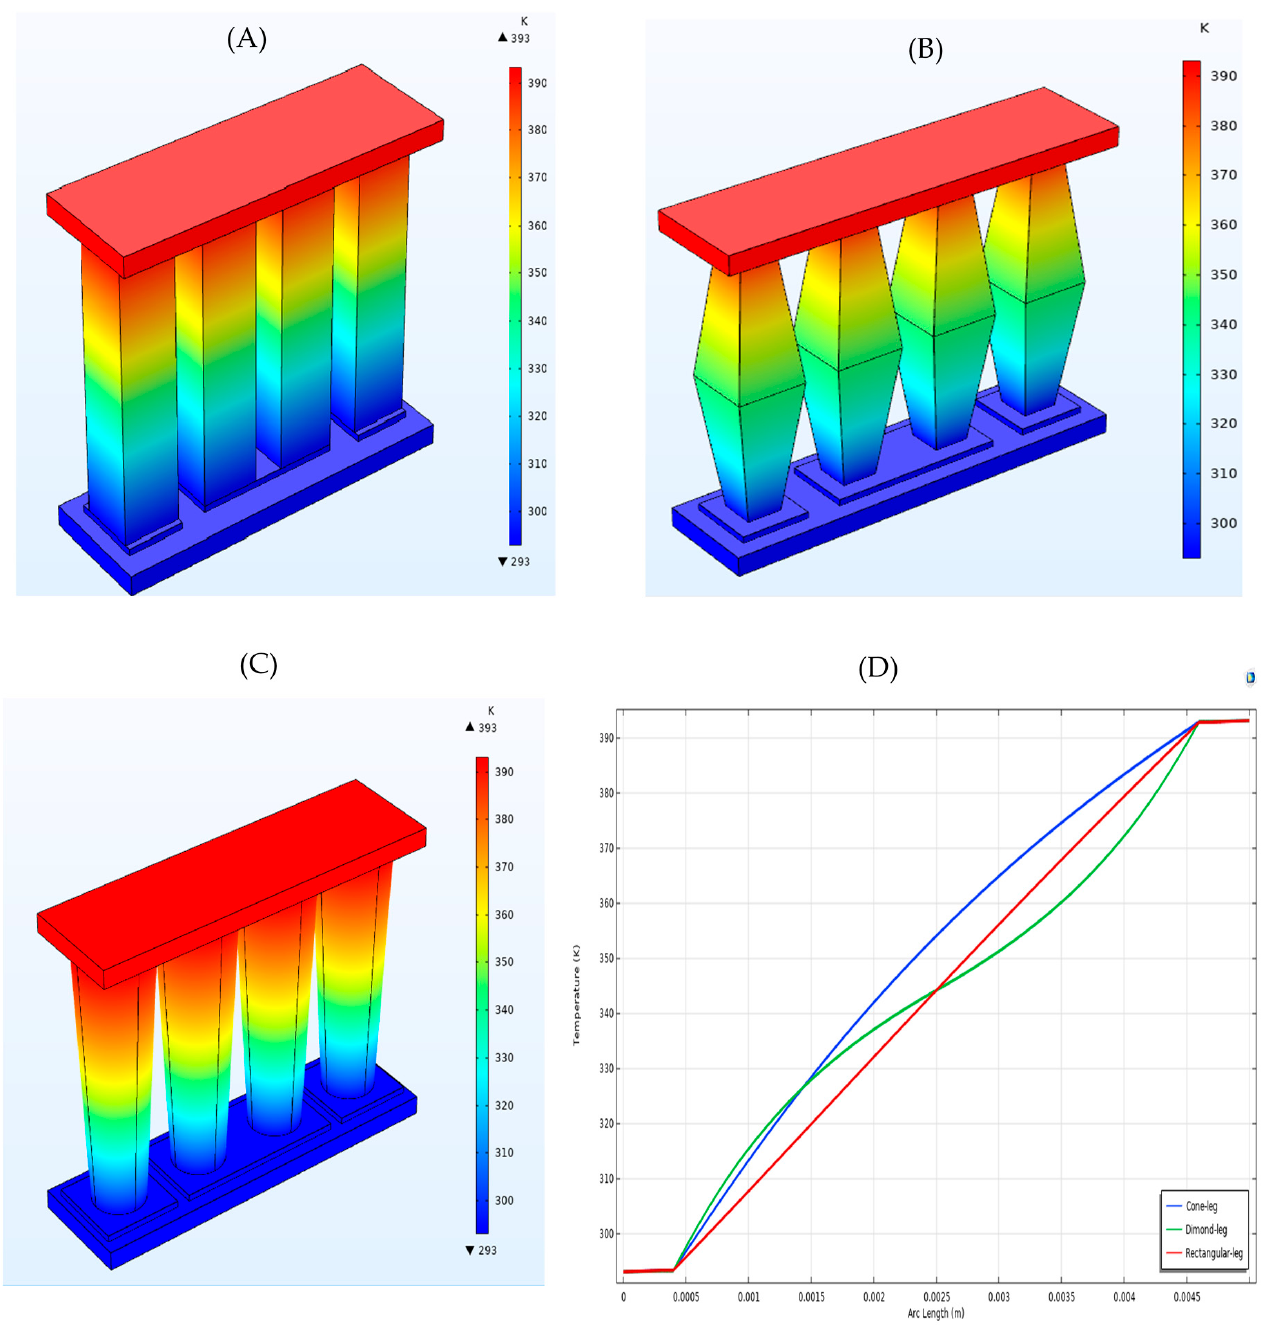
Figure 3. Comparison of TEG Temperature Distributions of ( A ) Rectangular shape, ( B ) Diamond shape, ( C ) Cone shape and ( D ) temperature distributions for the geometries analysed.